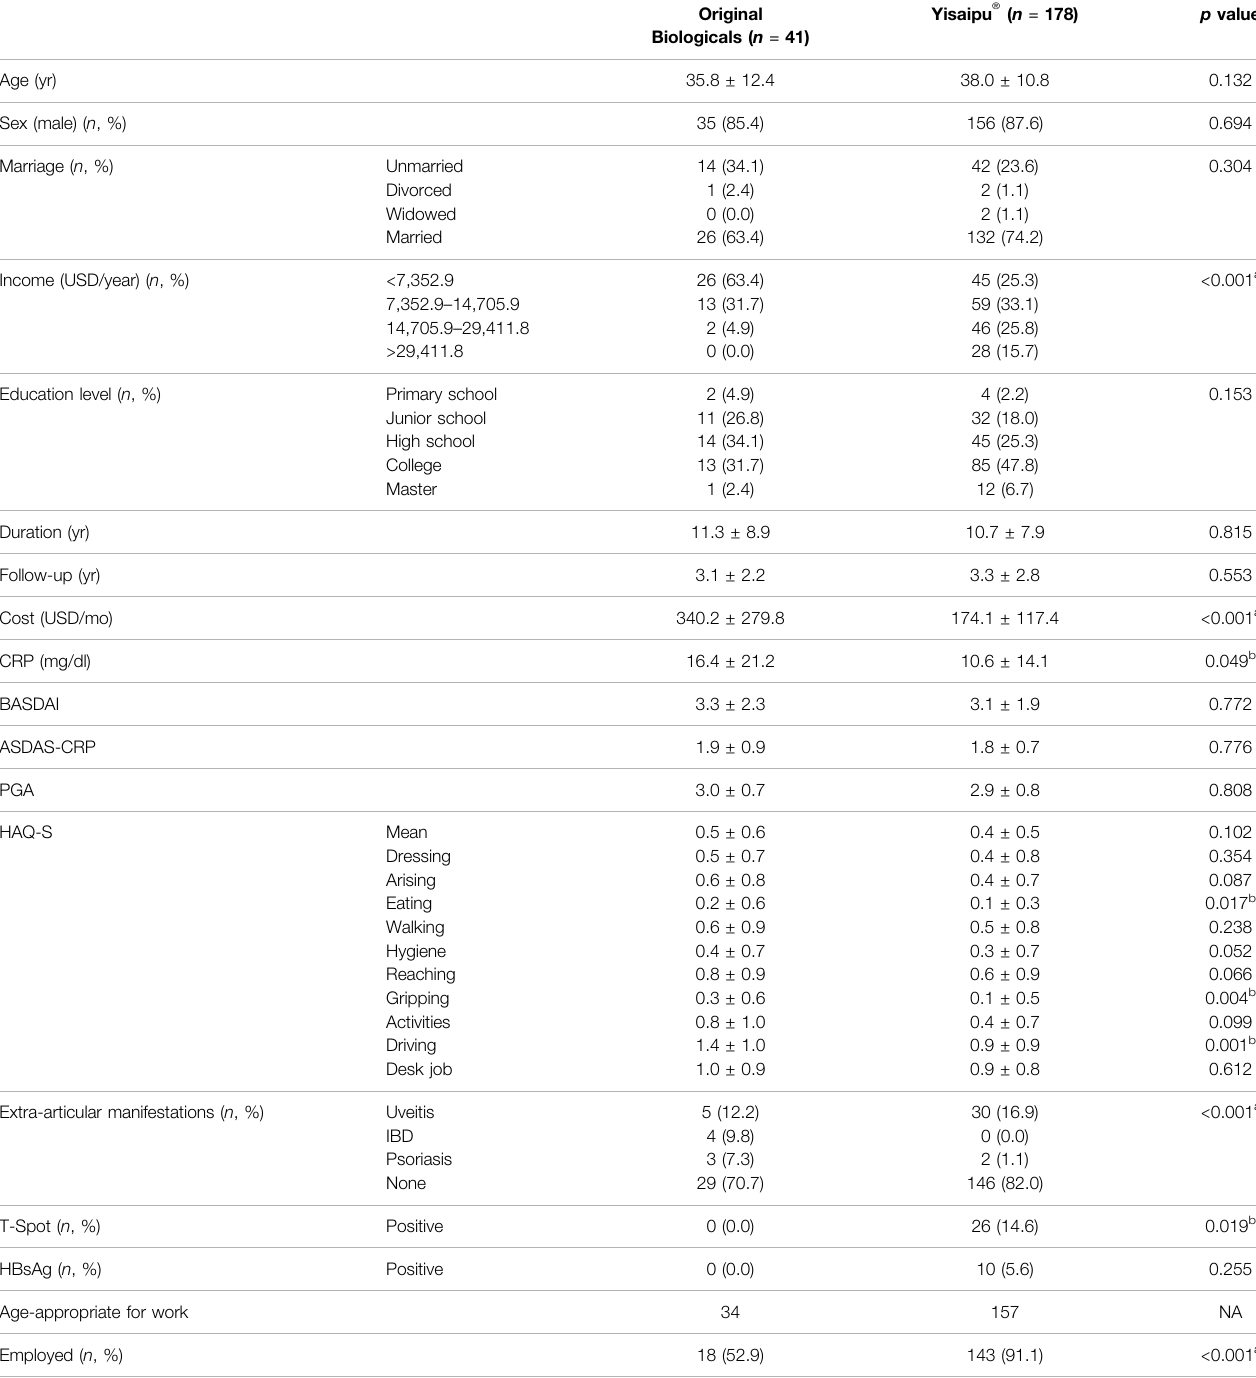
TABLE 1 | Patient demographic characteristics and clinical